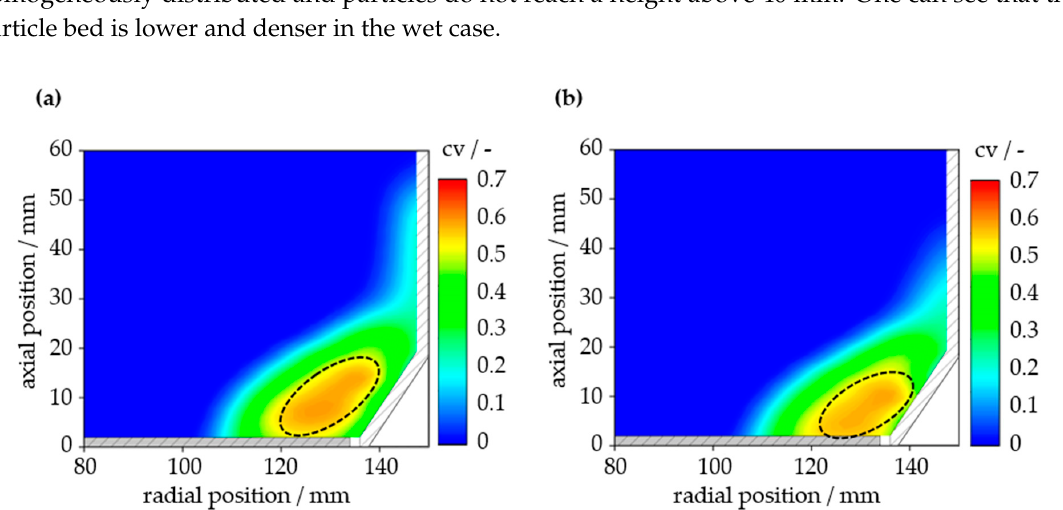
Figure 6. Average contact force acting on the particle ( a ) and average particle velocity ( b ) for the dry and wet case. During the coating process, the amount of water in the system increases linearly because of the constant injection volume flow and the constant drying rate. In Figure 7a, the constant increase of the total liquid volume of all particles in the process over time is shown. After 58 s of injection, 91 mL of liquid remains distributed on the particles, corresponding to 94.1% of the injected liquid. A total of 5.6 mL is on the walls of the apparatus. The low drying rate results in very low liquid reduction over time. Due to the wetting of the particles, liquid bridges are formed in the wet contacts. The number of formed liquid bridges increases strongly in the first three seconds. The rupture of the liquid bridges starts later when more volume of the liquid is deposited on the particles (Equation (15)). Over time, a balance between newly formed and destroyed bridges is reached, with an average number of 1581